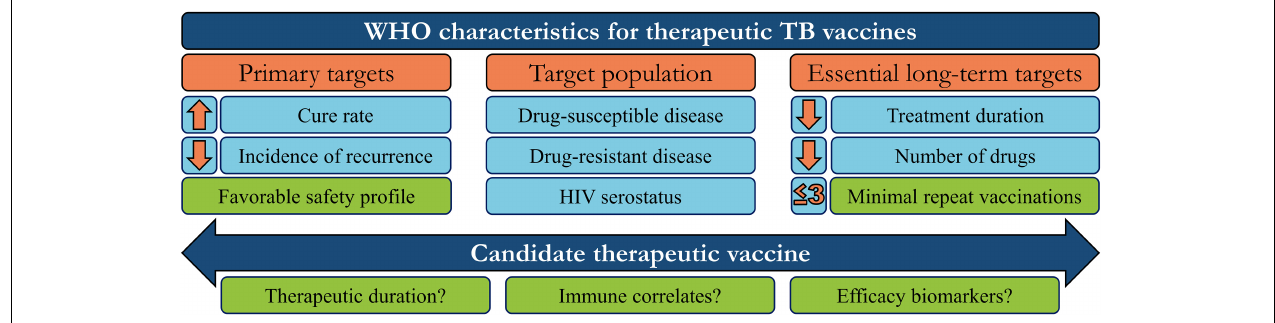
FIGURE 1 | WHO target characteristics for therapeutic tuberculosis vaccines. In order to guide research and development, the WHO has set aspirational targets/characteristics for candidate therapeutic TB vaccines. These include three major areas to address (orange boxes): Vaccine targets that determine efficacy, the target population, and the subsequent long-term impact on the chemotherapy regimen. Candidates which meet some/all of these targets must also be safe, efficacious in a minimum number of repeated doses, and investigated to define their mechanism-of-action or potential efficacy biomarkers, to further refine/guide future vaccination strategies (green boxes).